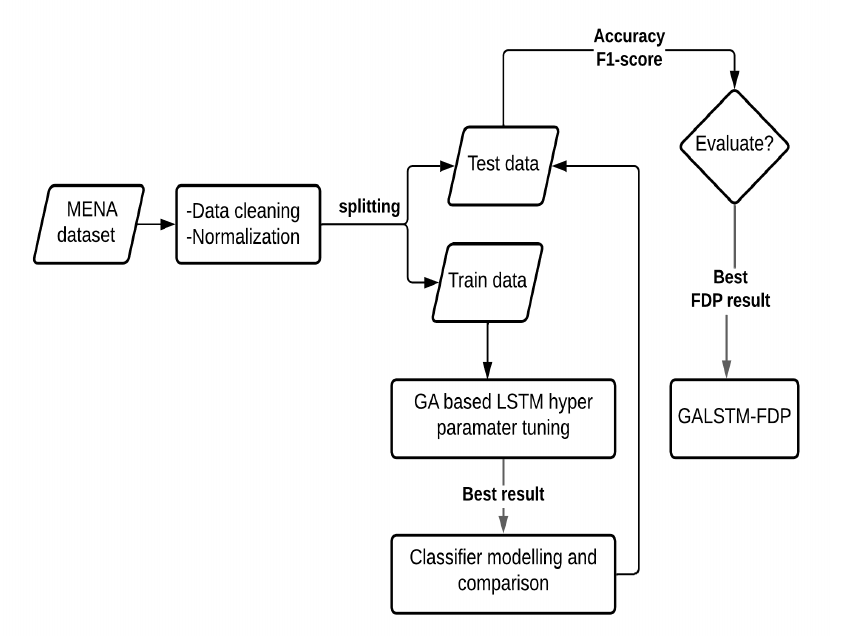
Figure 2. Flow diagram of the GALSTM-FDP model for